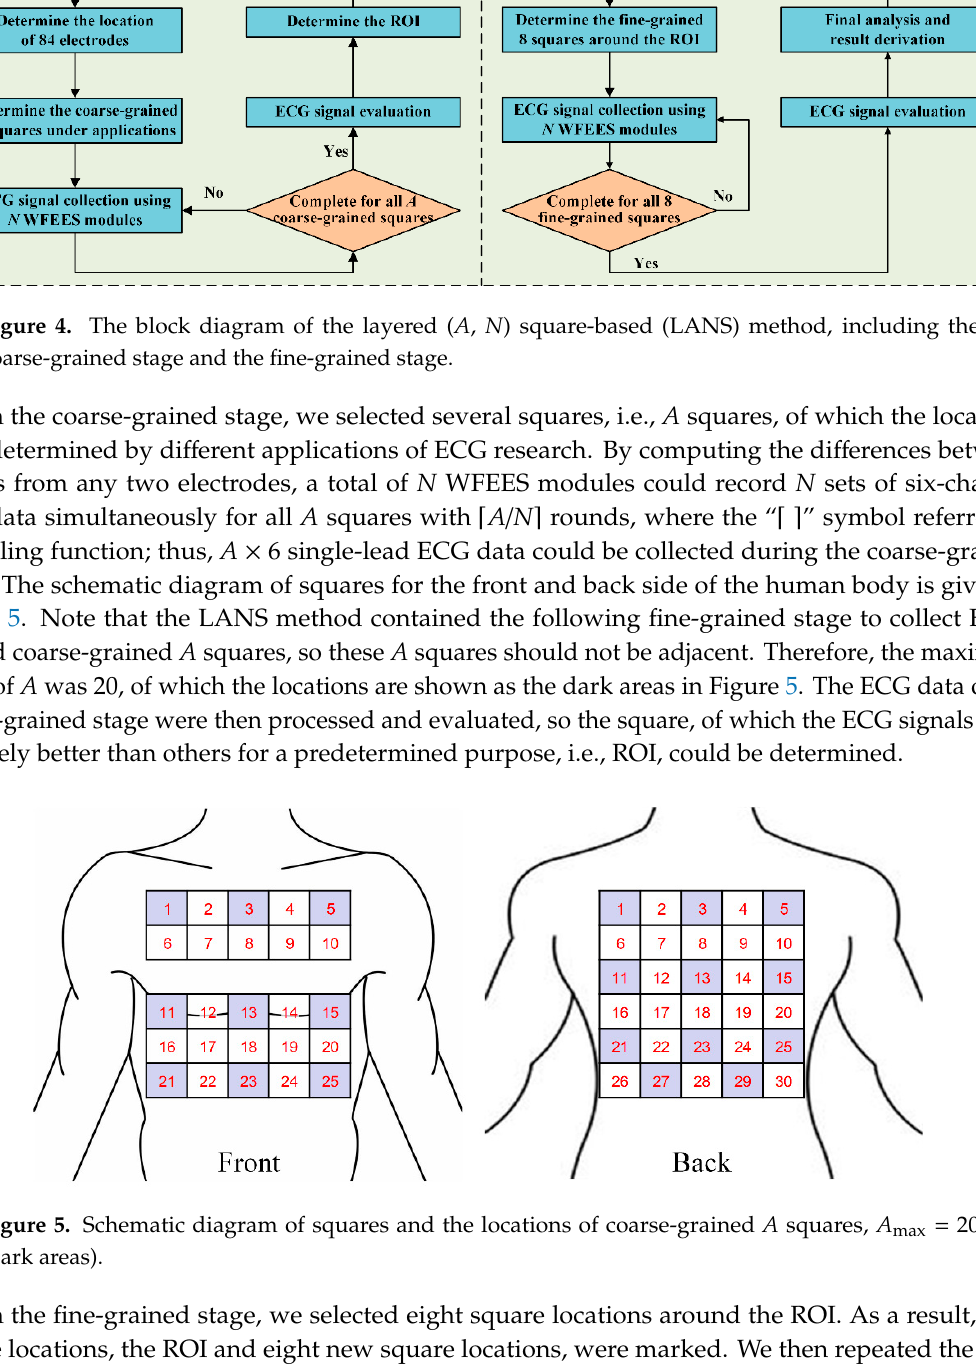
8 / N rounds. Finally, the reasonable